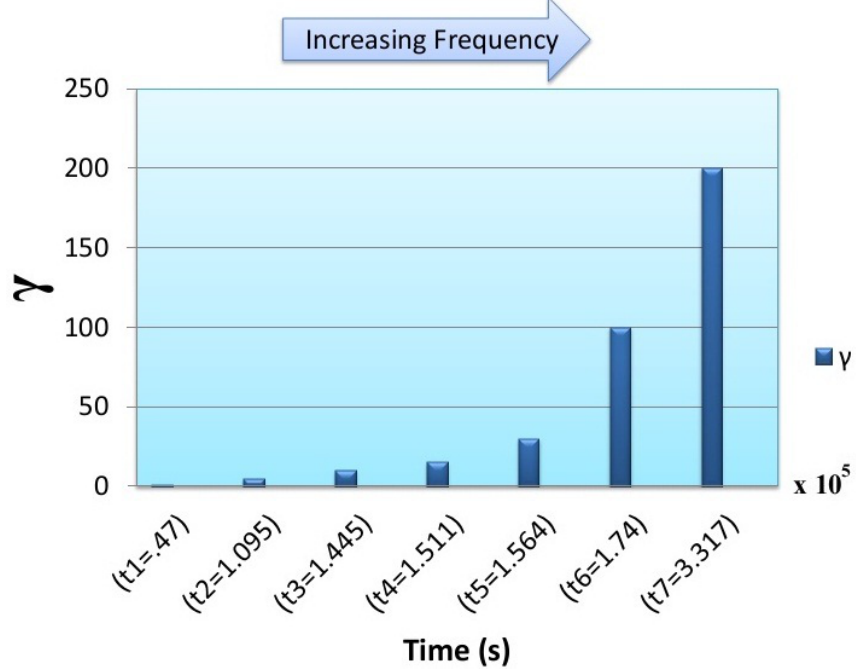
Figure 4. Effect of feedback coupling coefficient γ on the frequency and spiking interval of post- synaptic neuron.